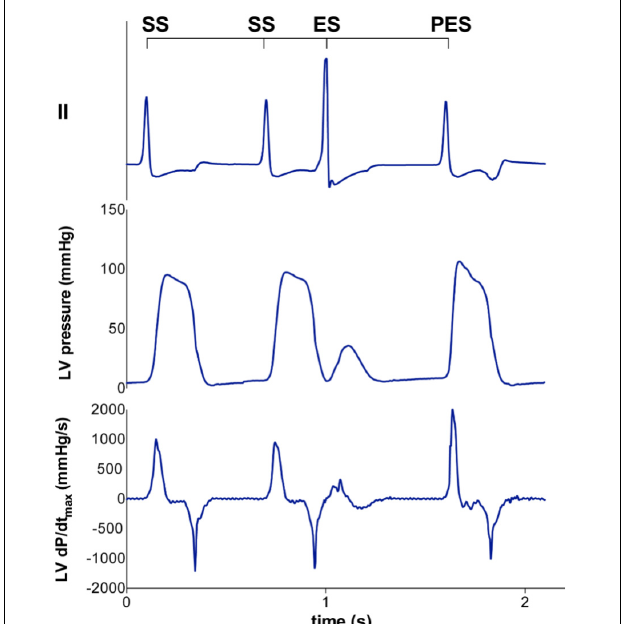
FIGURE 1 | Representative tracing of LV pressure and LV dP/dt max of the extrasystolic and postextrasystolic beat. A steady state stimulation train (SS) is interrupted with an extrasystolic beat (ES) at different coupling interval (CI), followed by a post-extrasystolic beat (PES) at a fixed CI. With decremental CI of the ES, the LV dP/dt max of the ES decreases, while the LV dP/dt max of the PES